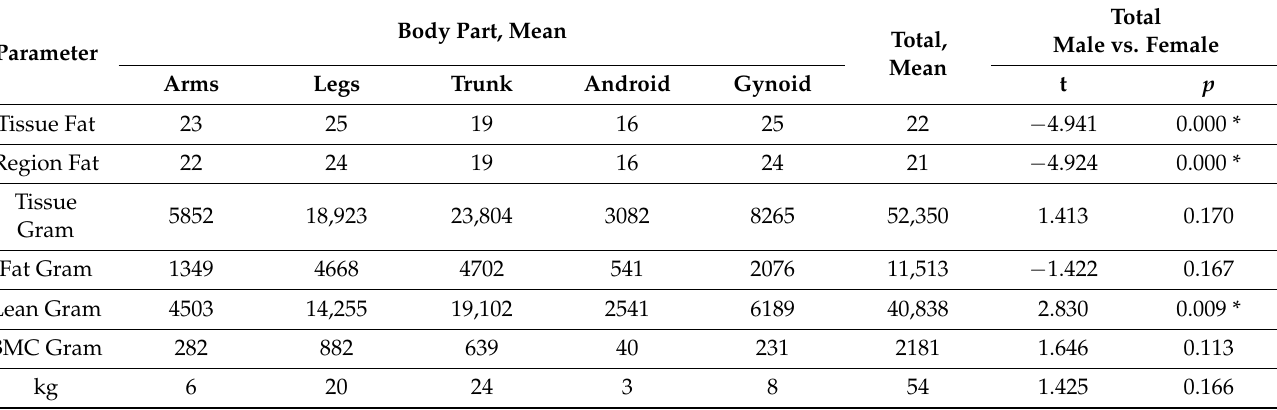
Table 3. Biological parameters’ means and their gender-based comparisons ( n =